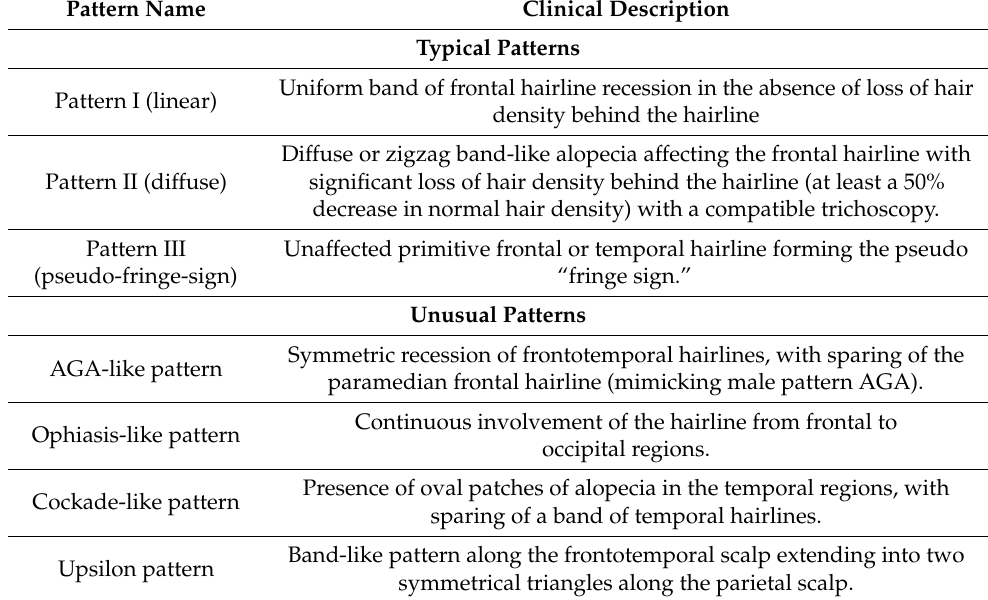
Figure 3. ( a ) Recession of both fronto-temporal hairlines, mimicking male AGA (AGA-like pattern). ( b , c ) Recession of the whole hairline, from frontal to occipital (ophiasis-like pattern). ( d ) Oval alopecic patches in the temporal region, sparing a thin band of temporal hairline (cockade-like pattern). ( e ) Recession of temporal hairline extending upwards to the parietal scalp (upsilon pattern). In this patient, the frontal hairline is also affected, but not the occipital area, and neither is the retroauricular region. Table 2. Typical and unusual patterns of